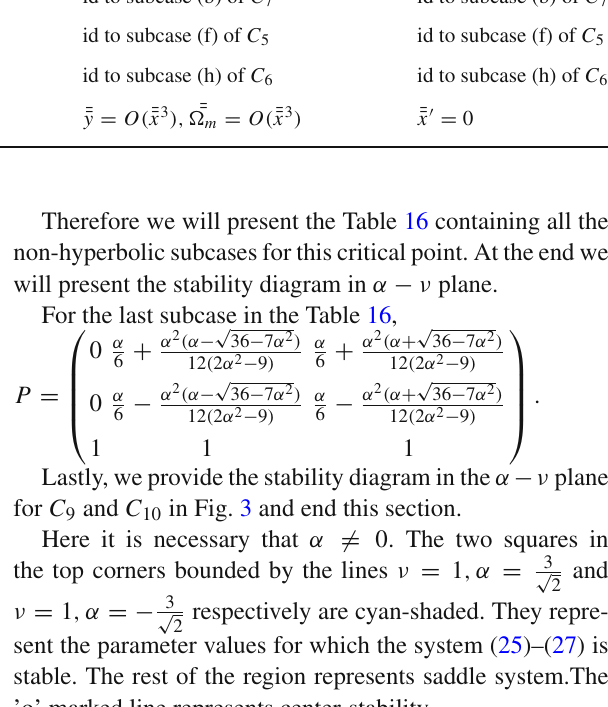
Table 15 C 9 (reduced